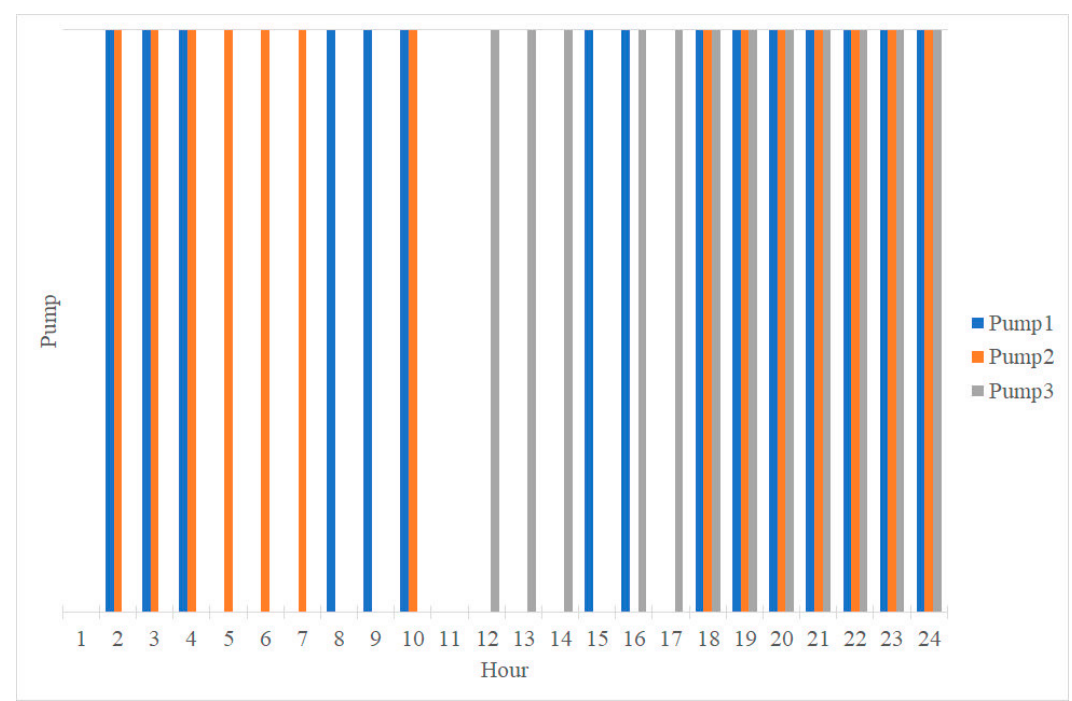
Figure 3. Best ON / OFF patterns solution. Figure 3. Best ON/OFF patterns solution.